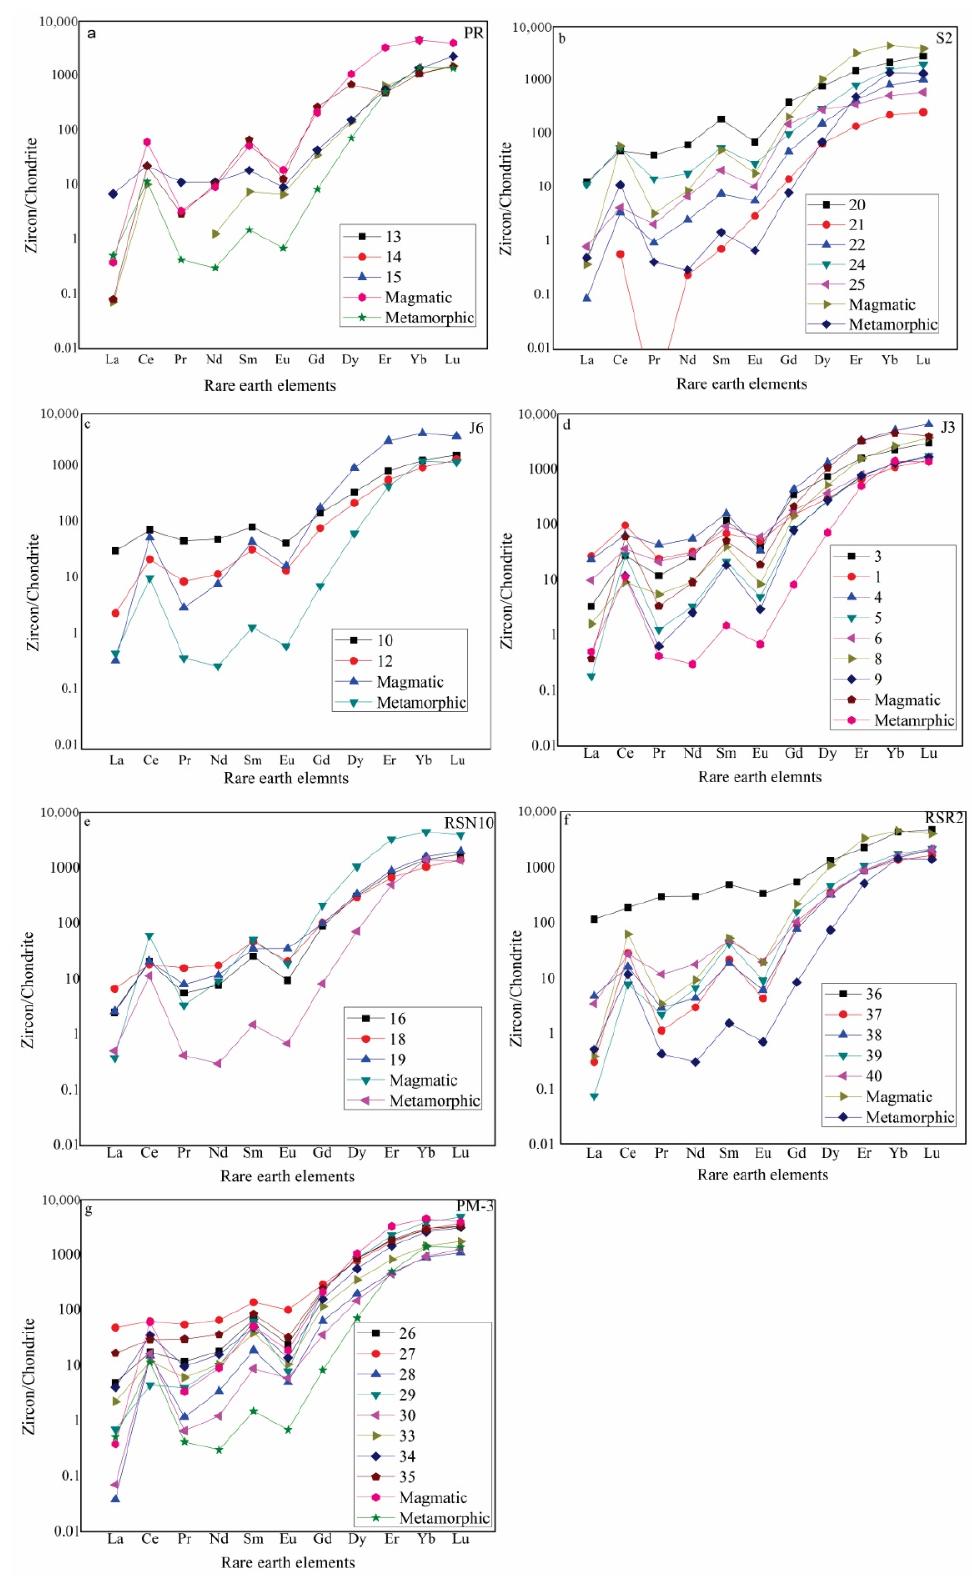
Figure 7. Chondrite-normalized diagram of REEs obtained from zircon samples. Chondrite values were obtained from [30]. Values of magmatic zircon and metamorphic zircon obtained from [34]. ( a ): sample PR; ( b ): sample S2; ( c ): sample J6; ( d ): sample J3; ( e ): sample RSN10; ( f ): sample RSR2,